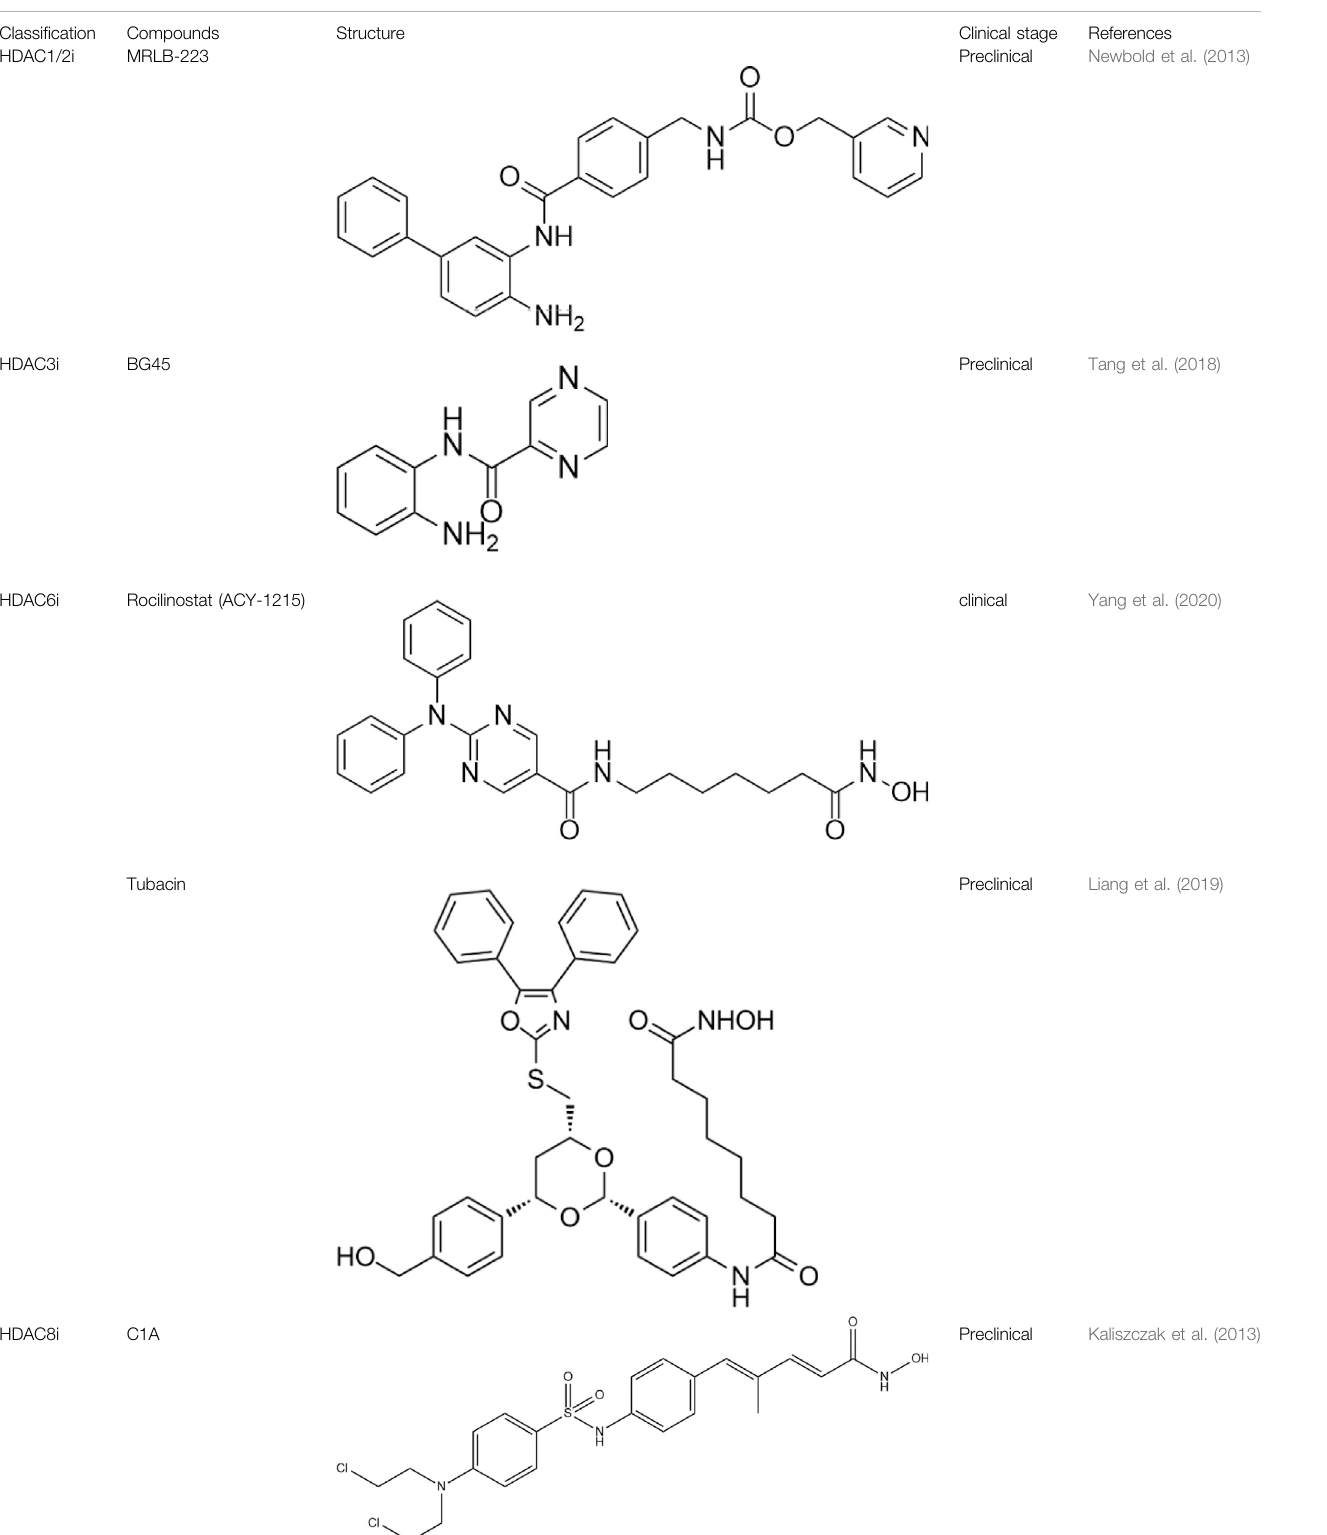
TABLE 5 | A list of histone deacetylase inhibitors under different phases of clinical trial and their indication. Histone acetyltransferase